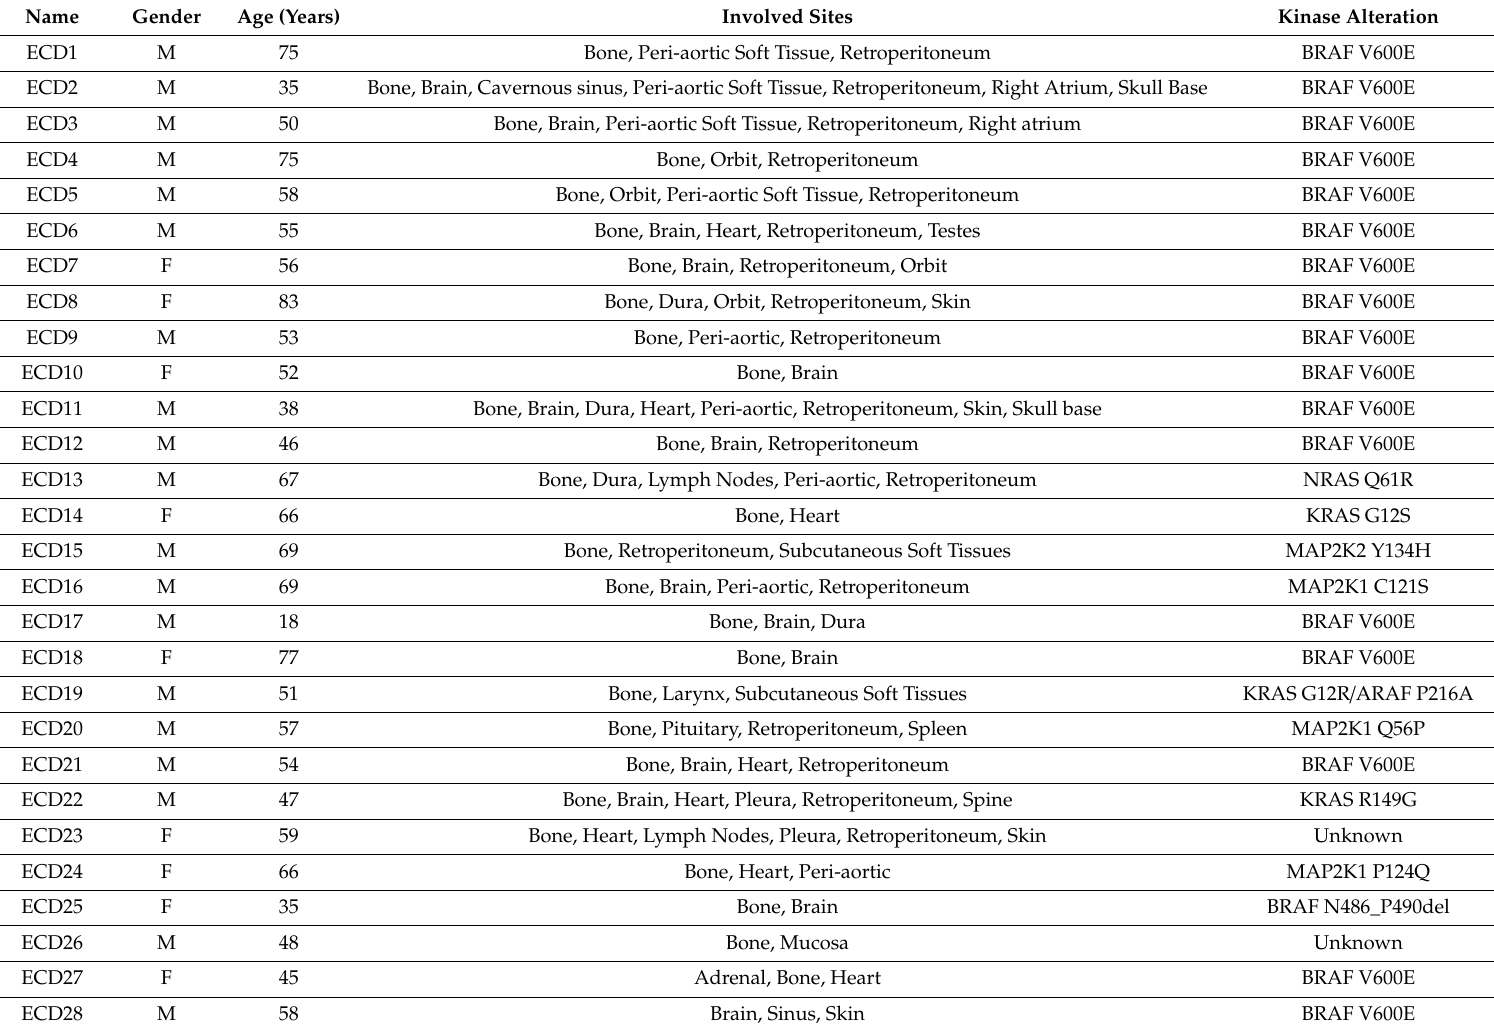
Table 1. ECD and LCH patient characteristics (Plasma